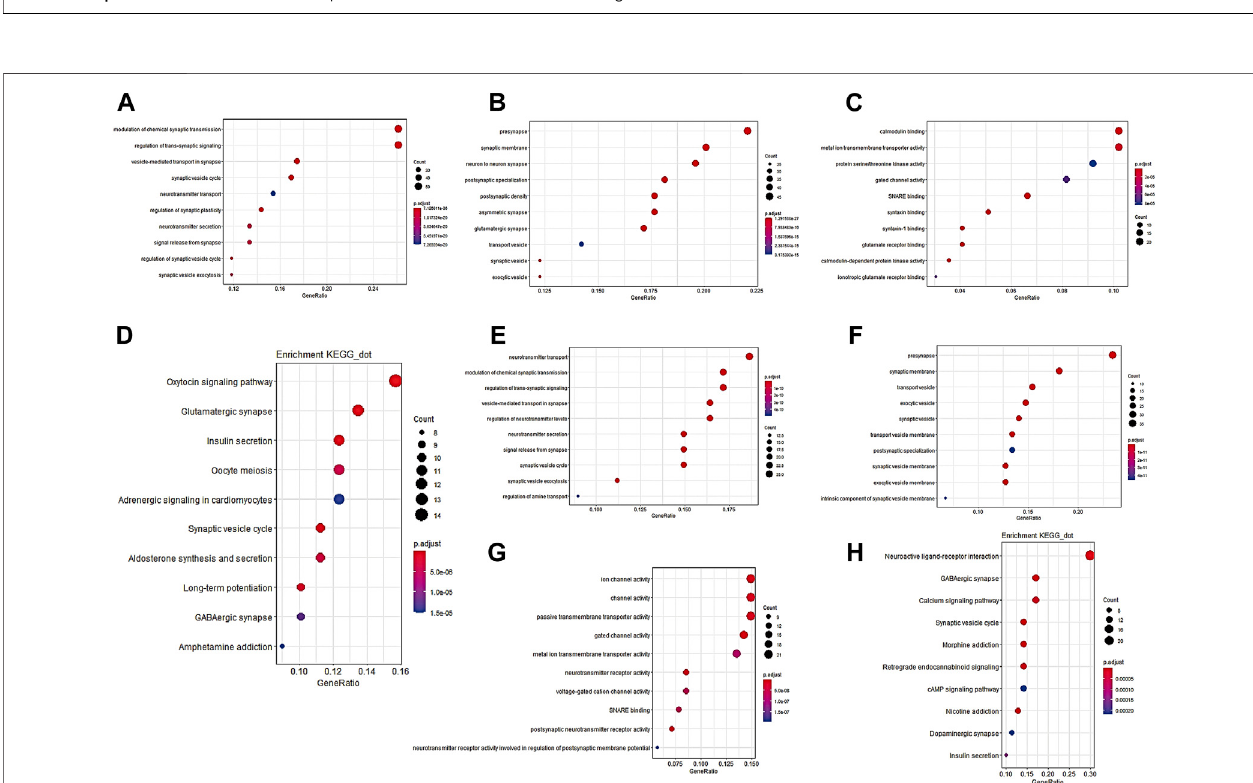
FIGURE7| GOfunctionannotationandKEGGpathwayanalysisresultsof224DEGs.DEGsinCGGAdatasetGOpathwayenrichmentanalysisresultsBP (A) ,CC (B) , MF (C) , KEGG pathway enrichment analysis results (D) . DEGs in TCGA dataset GO pathway enrichment analysis results BP (E) , CC (F) , MF (G) , KEGG pathway enrichment analysis results (H) P. adjust: p value of gene enrichment. Counts: number of genes in a cluster of DEGs that belong to this pathway.